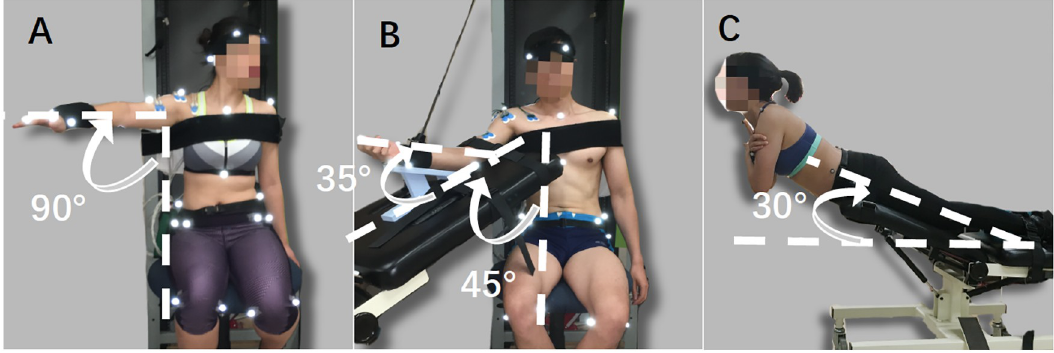
Fig 2. Shoulder, elbow and lower back fatiguing protocol setups. From the figure A to C are the figures showing the shoulder, elbow and lower back fatiguing protocols, respectively.